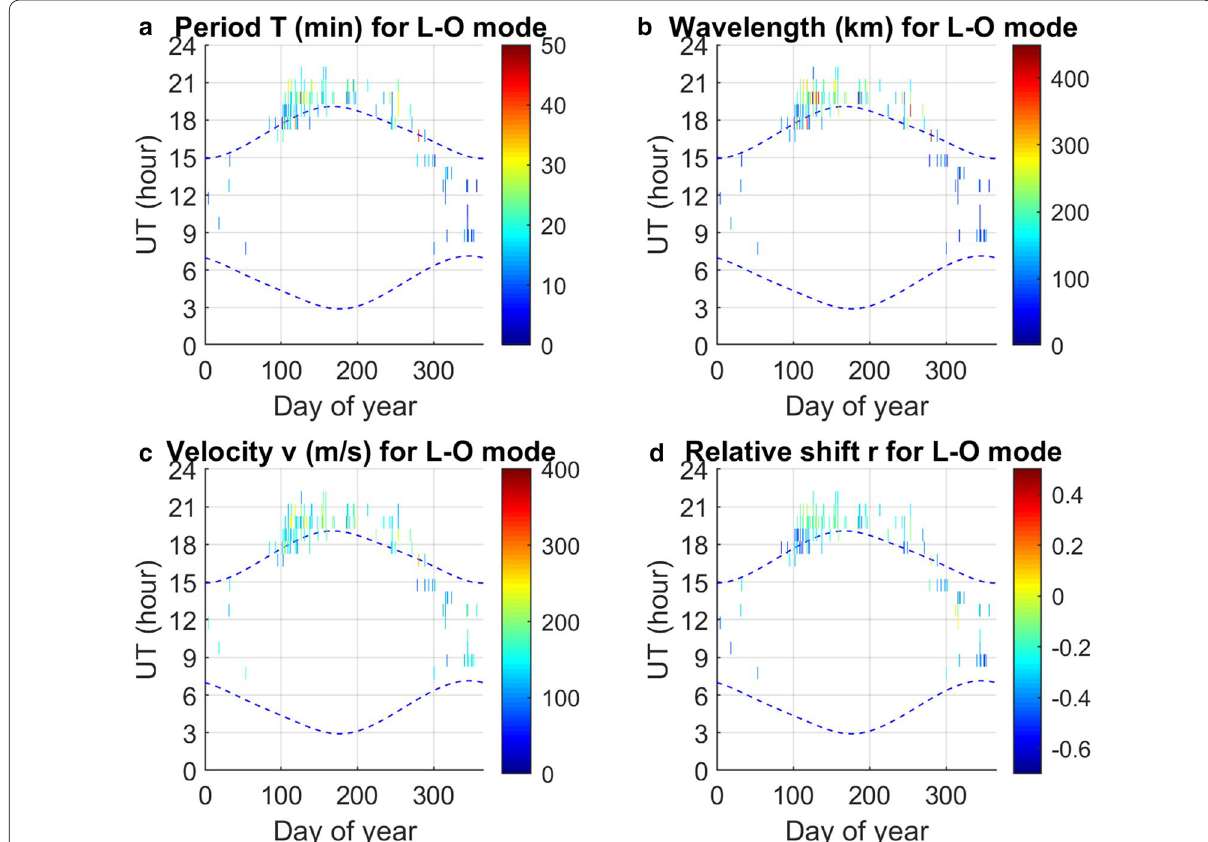
Fig. 10 Period T , wavelength λ , velocity v and relative Doppler shift r for the period September 2018–August 2019 (solar minimum) and L-O mode. The values are color-coded. Dashed lines indicate times of sunrise and sunset